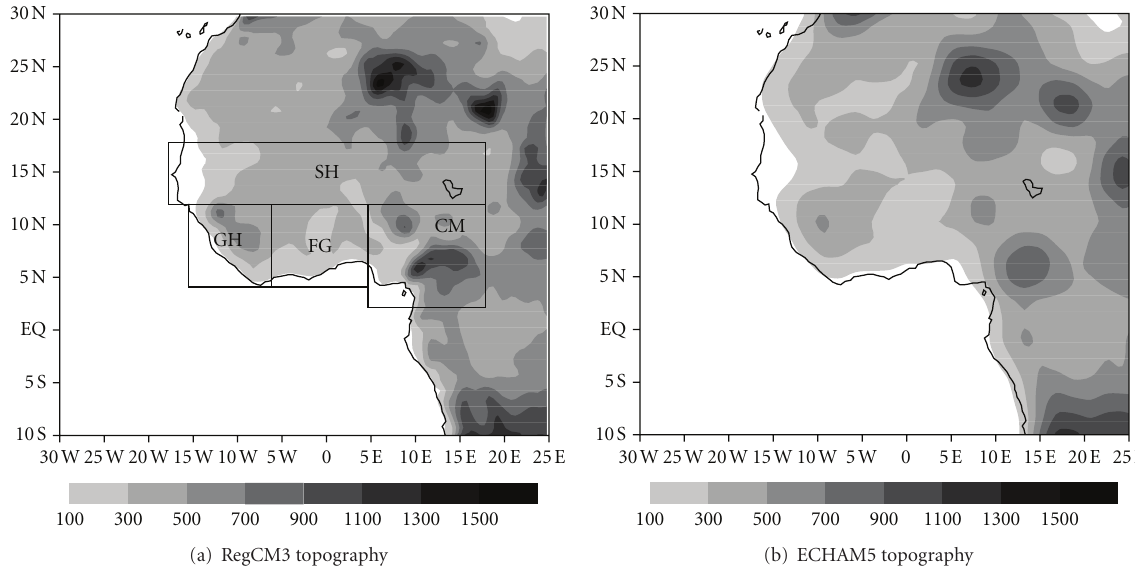
Figure 1: Interior domain, topography, and subregions. SH stands for Sahel; GH: Guinea Highlands; FG: Flatter (low-elevation terrains) of Gulf of Guinea; CM: Cameroun Mountains.